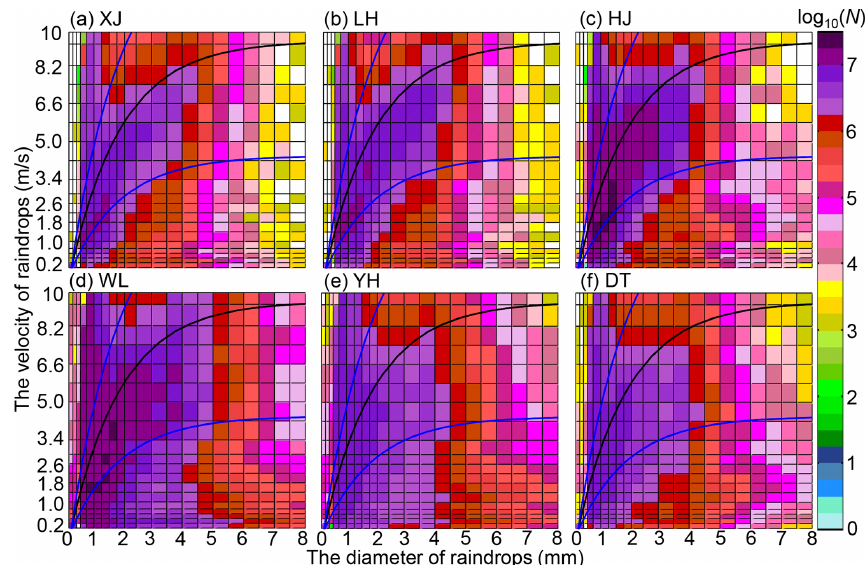
Figure 5. The original size–velocity dataset collected at (a) XJ, (b) LH, (c) HJ, (d) WL, (e) YH, and (f) DT. The black and blue lines refer to the fall speed V B , 0.5 V B , and 1.5 V B calculated in Eq. (3).